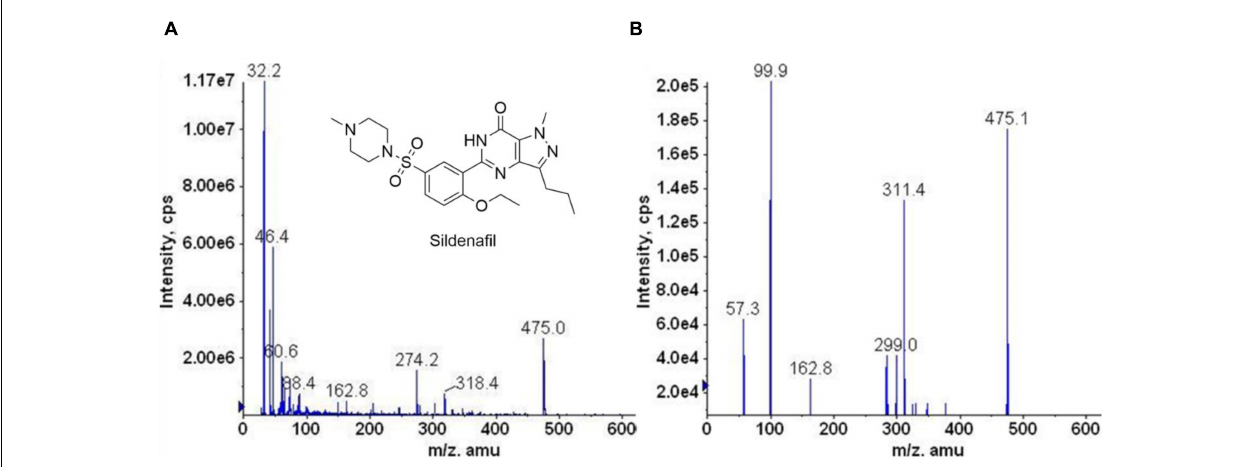
Figure 1 | The chemical structure of sildenafil and its MS/MS spectrum. (A) Mass-spectrogram of the parent ion. The illustration shows the chemical structure of sildenafil. (B) Mass-spectrogram of fragmentation.